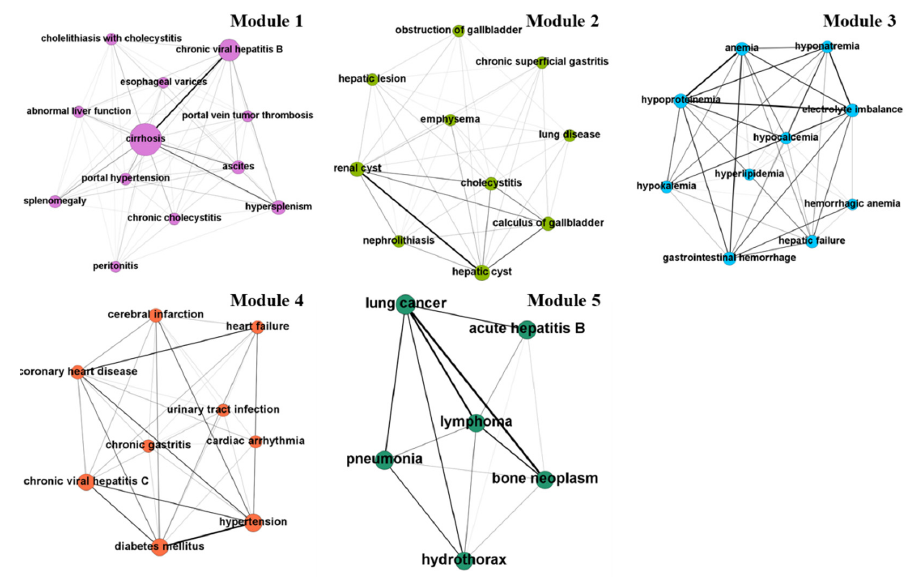
Figure 4. The HCC comorbidity modules.